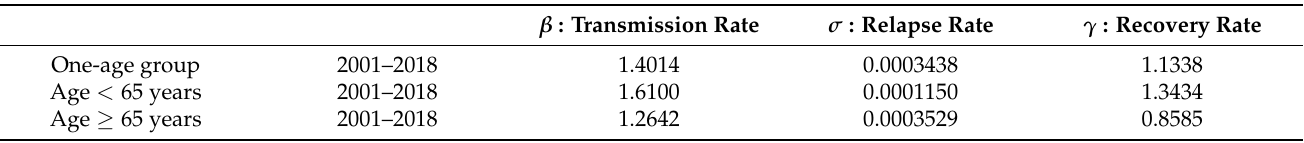
Table 5. Parameter estimation for a 1-time window from 2001 to 2018. Age-specific transmission rates, relapse rate, and recovery rates were estimated according to TB incidence in South Korea. β : Transmission Rate σ : Relapse Rate γ : Recovery Rate One-age